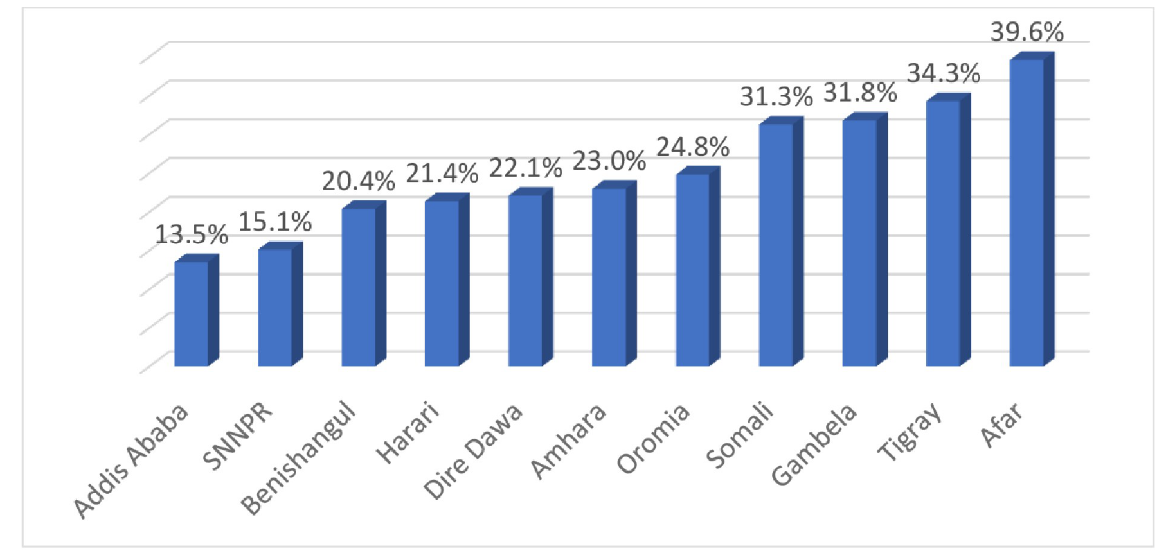
Fig 2. The magnitude of underweight among reproductive-age women by region; 2016